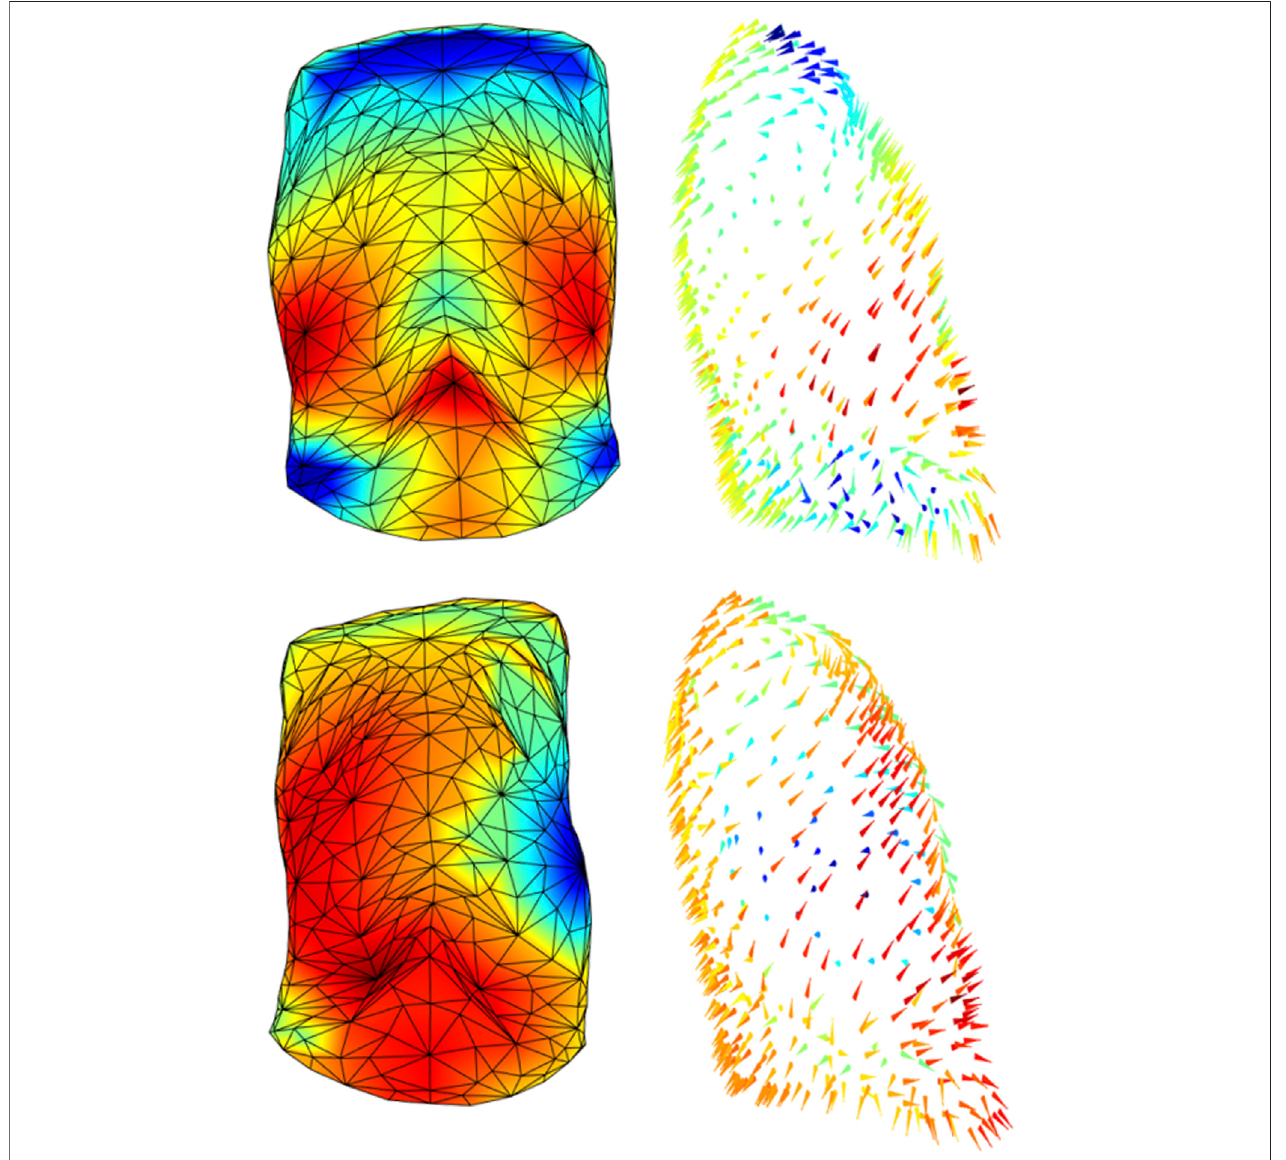
FIGURE 6 | Colormaps of the magnitude (left panels) and vector direction (right panels) of the trunk motion during the tidal volume of a patient before (top panels) and after(bottom panels)ademolition surgeryofhisleftribcage.Sincethesurgicalprocedurewasinevitablytailored tothepatient,theimpact onthechestwalldoesnot follow a strictly “ compartmental ” logic but it was more diffused among compartments, rather than con fi ned to a “ speci fi c ” compartment. It is also evident that patient passed from an almost perfectly symmetric breathing expansion to a paradoxical inward inspiratory movement of his left side (blue triangles, bottom panel).